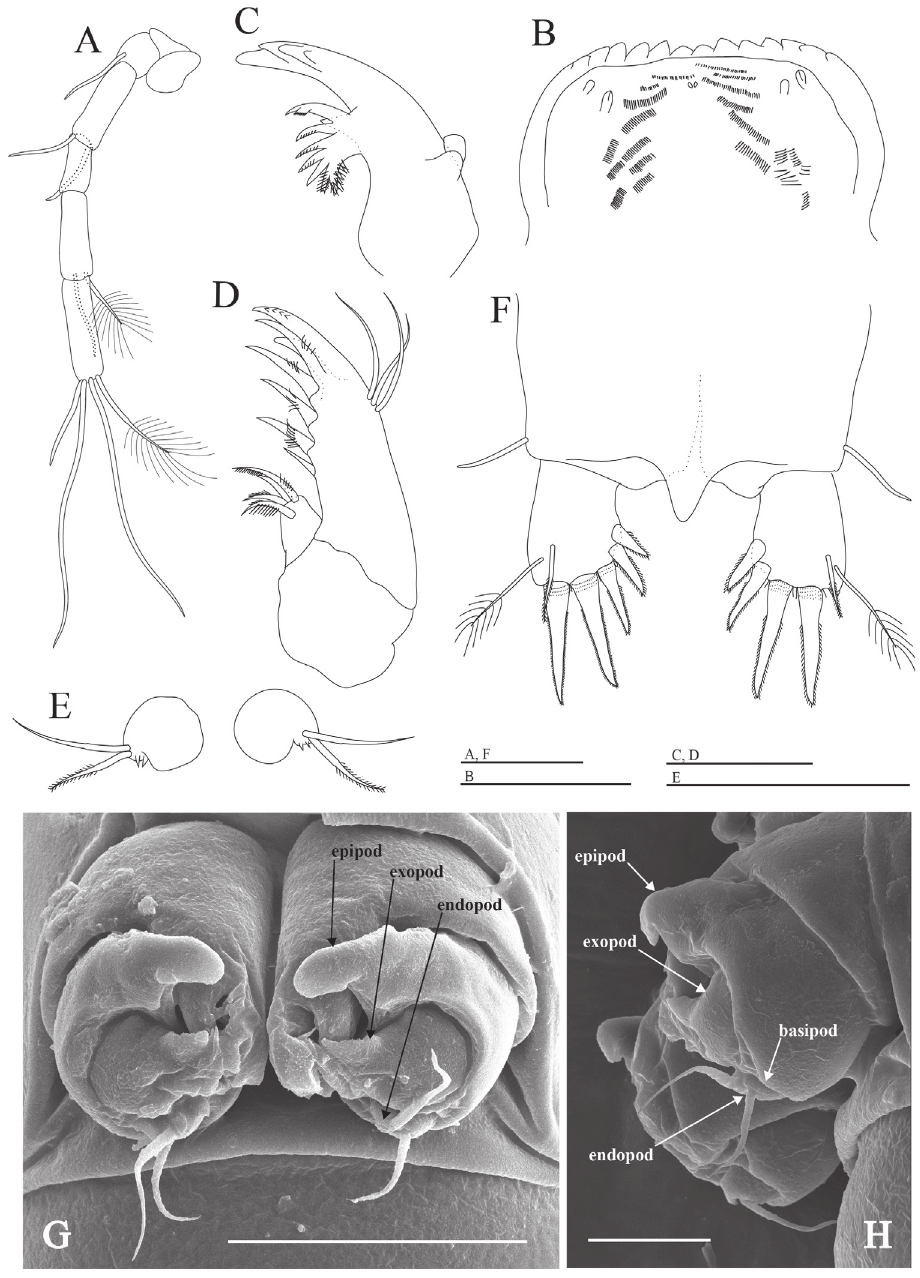
Figure 6. Hangangbathynella mihoensis sp. nov. A–D, F paratype female (NIBRIV0000881724) E allotype female G, H paratype male (NIBRIV0000881731) A antenna (ventral) B labrum (ventral) C mandible (dorsal) D maxillule (dorsal) E thoracopod VIII (ventral) F pleotelson and furcal rami (dor- sal) G thoracopod VIII (ventral) H thoracopod VIII (lateral). Scale bars: 0.05 mm ( A–G ); 0.02 mm ( H